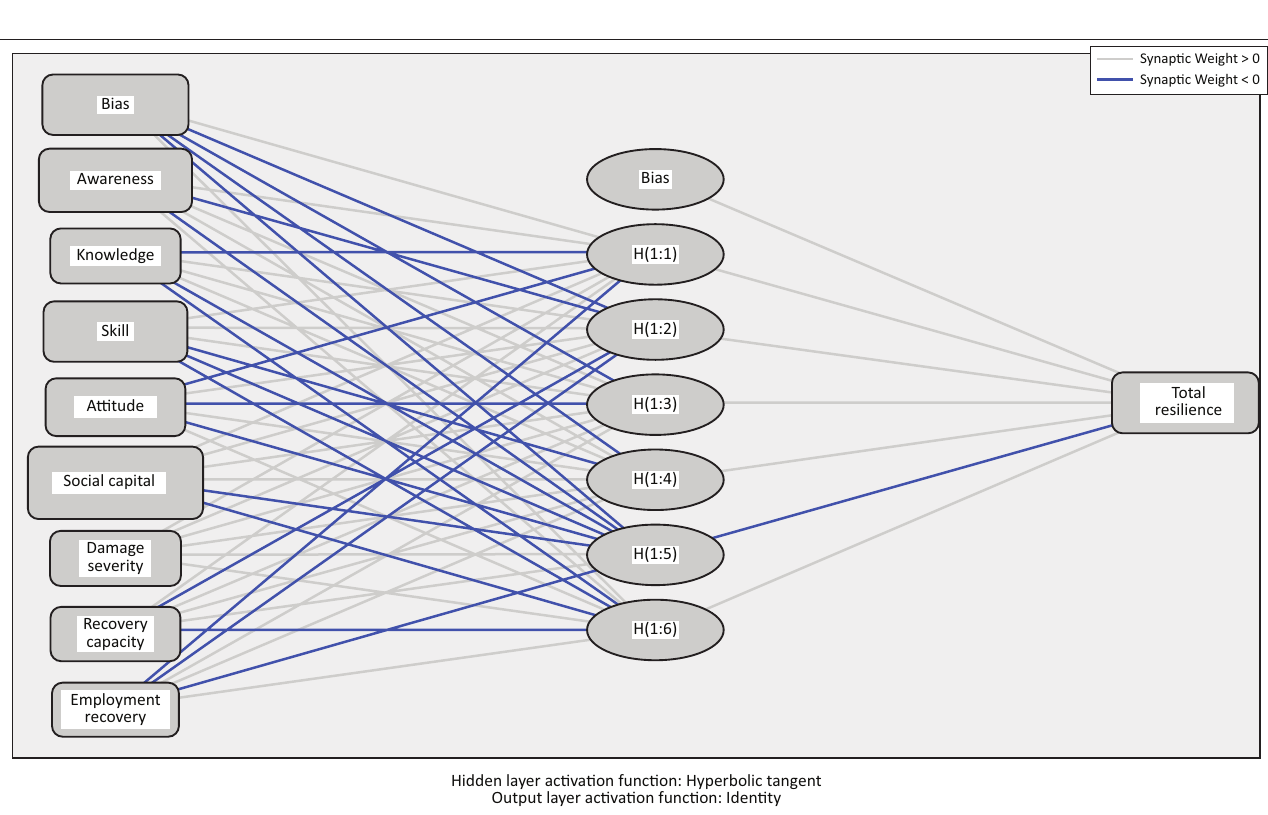
FIGURE 2: Structure of the artificial neural network of Bam including estimated synaptic